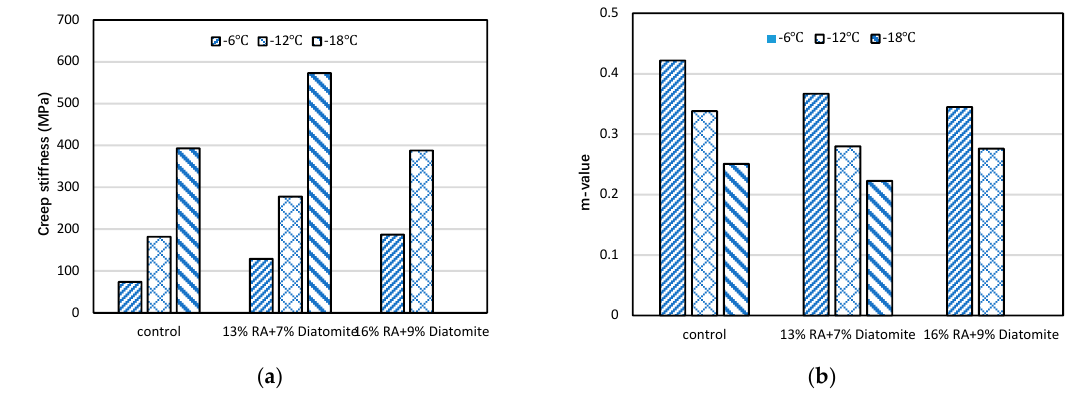
Figure 5. The BBR test results: ( a ) creep stiffness and ( b ) m-value.